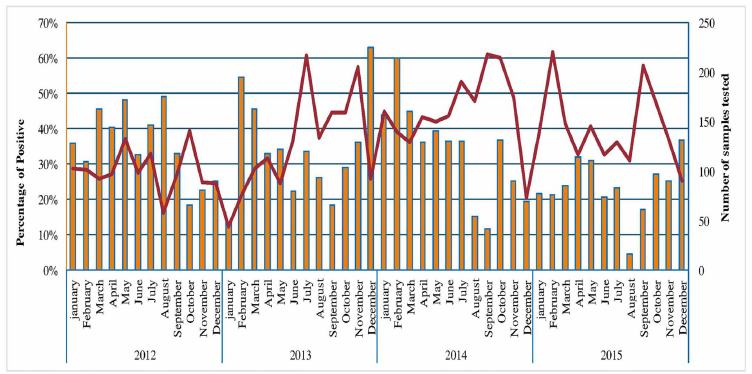
Fig 1. Distribution of adenovirus-positive cases among patients with influenza-like illness, by month and year. The curve represents the total number of influenza-like Illness cases tested for adenovirus. Bars representthe proportions (rates) of adenovirus-positive cases for each